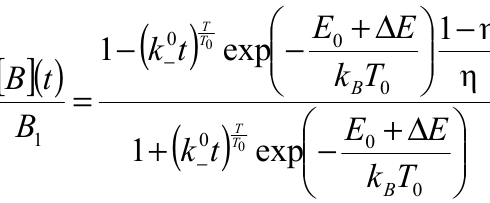
Figure 34. η (the proportion to saturation of the gratings) is found at 72% ± 10%, the rate constant for the stability is 1.2 × 10 12 day − 1 ± factor 2, the pre-exponential factor is 2.5 × 10 − 4 ± 30% and T 0 =2670 ± 200